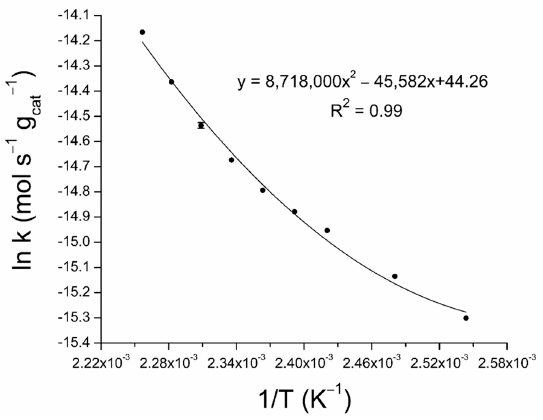
Figure 6. Sub-Arrhenius behavior plot for the S-HDO of xylitol. Table 2. Kinetic parameters for sub-Arrhenius behavior.